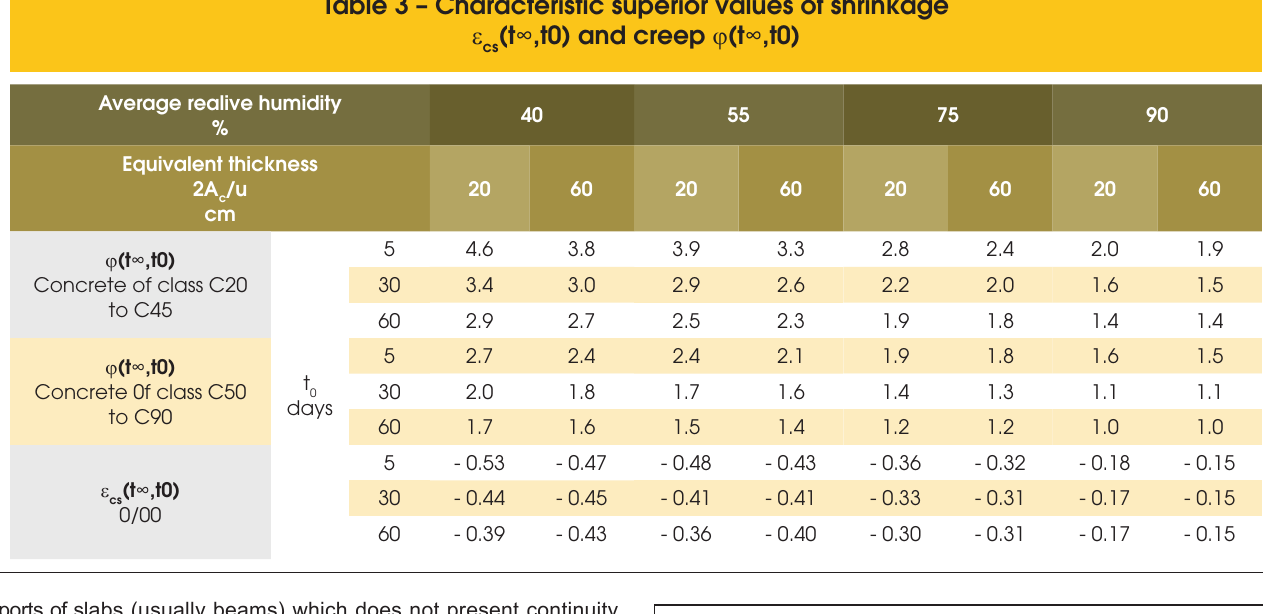
Table 3 – Characteristic superior values of